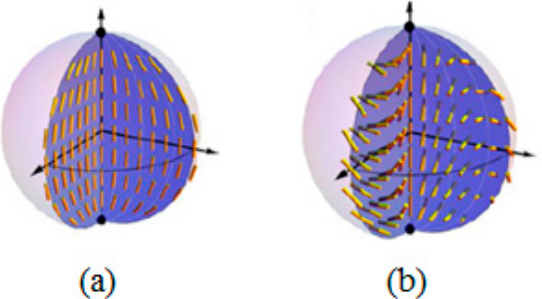
Figure 10. Schematic diagrams of ( a ) the bipolar configuration and ( b ) the twisted bipolar con- figuration. Reprinted with permission from ref. [40]. Copyright 2014, the National Academy of Sci- ences.